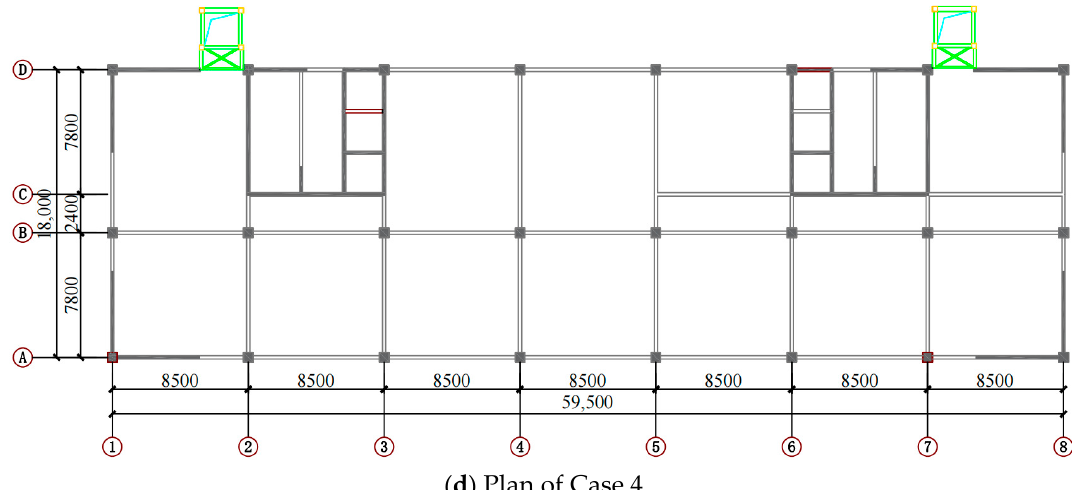
Figure 9. Elevator installation location plans(mm).